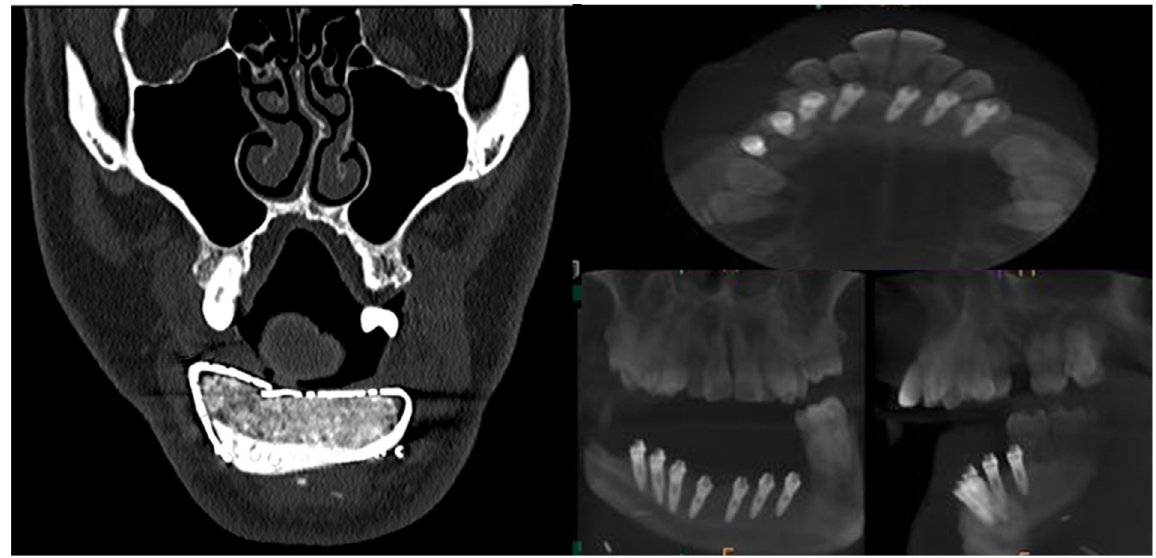
Figure 13. CT Scan and CBCT were performed in the postoperative follow-up, providing relevant quantitative data regarding bone volume and bone resorption.